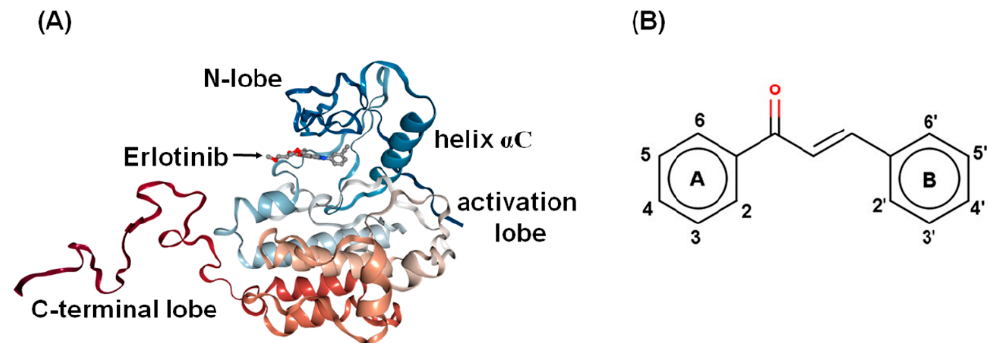
Figure 1. ( A ) Three-dimensional structure of the epidermal growth factor receptor tyrosine kinase (EGFR-TK) domain in the active conformation with erlotinib bound, as modeled from the crystal structure (PDB: 1M17), and ( B ) the chemical structure of natural chalcone, where its synthesized derivatives are taken from a previous study [39].